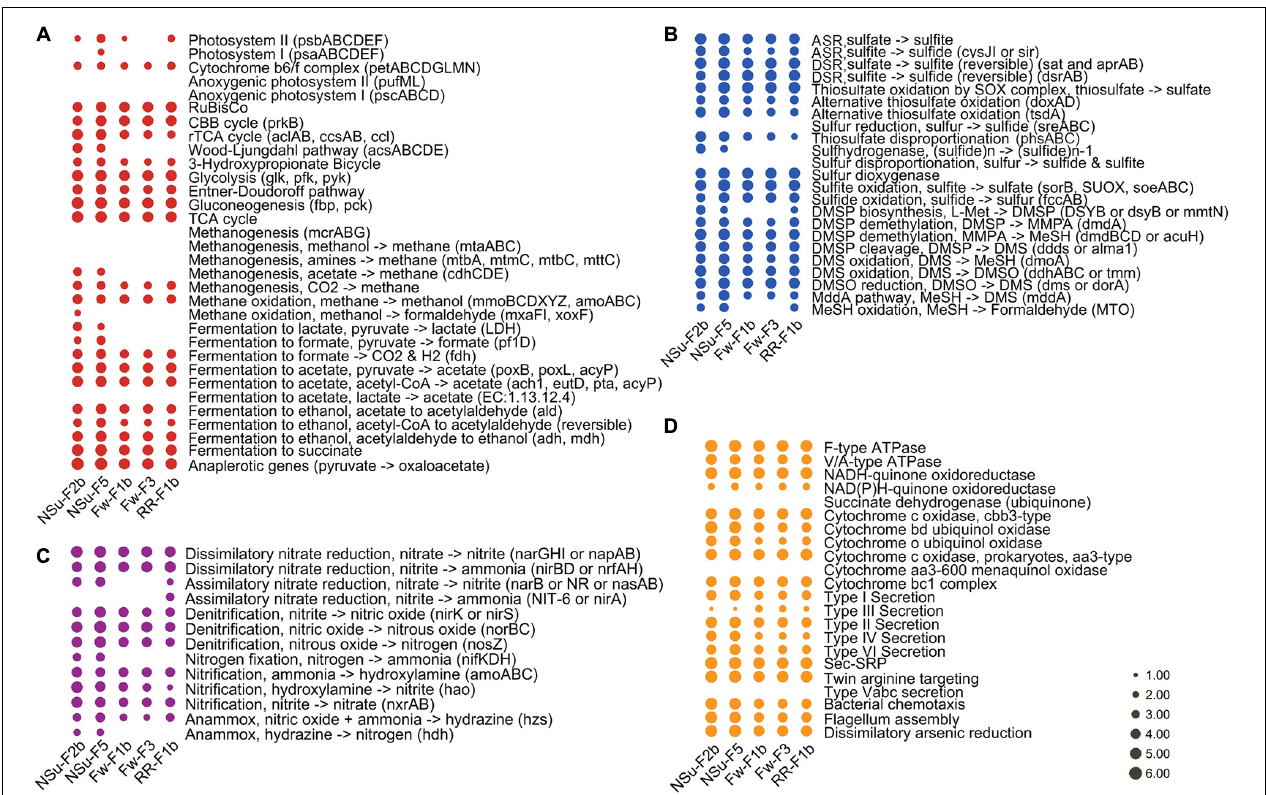
FIGURE 4 | Bubble plots depicting the relative abundance of pathways for carbon (A) , sulfur (B) , nitrogen (C) , and other selected (D) processes. The key marker genes used to report on the genetic potential for pathways (as the relative abundances) are indicated in brackets. ASR, assimilatory sulfate reduction; DSR, dissimilatory sulfate reduction. The full name of these key marker genes can be found in Supplementary Table 1 . For better visualization, we multiply the relative abundance by 10 3 and transformed it by